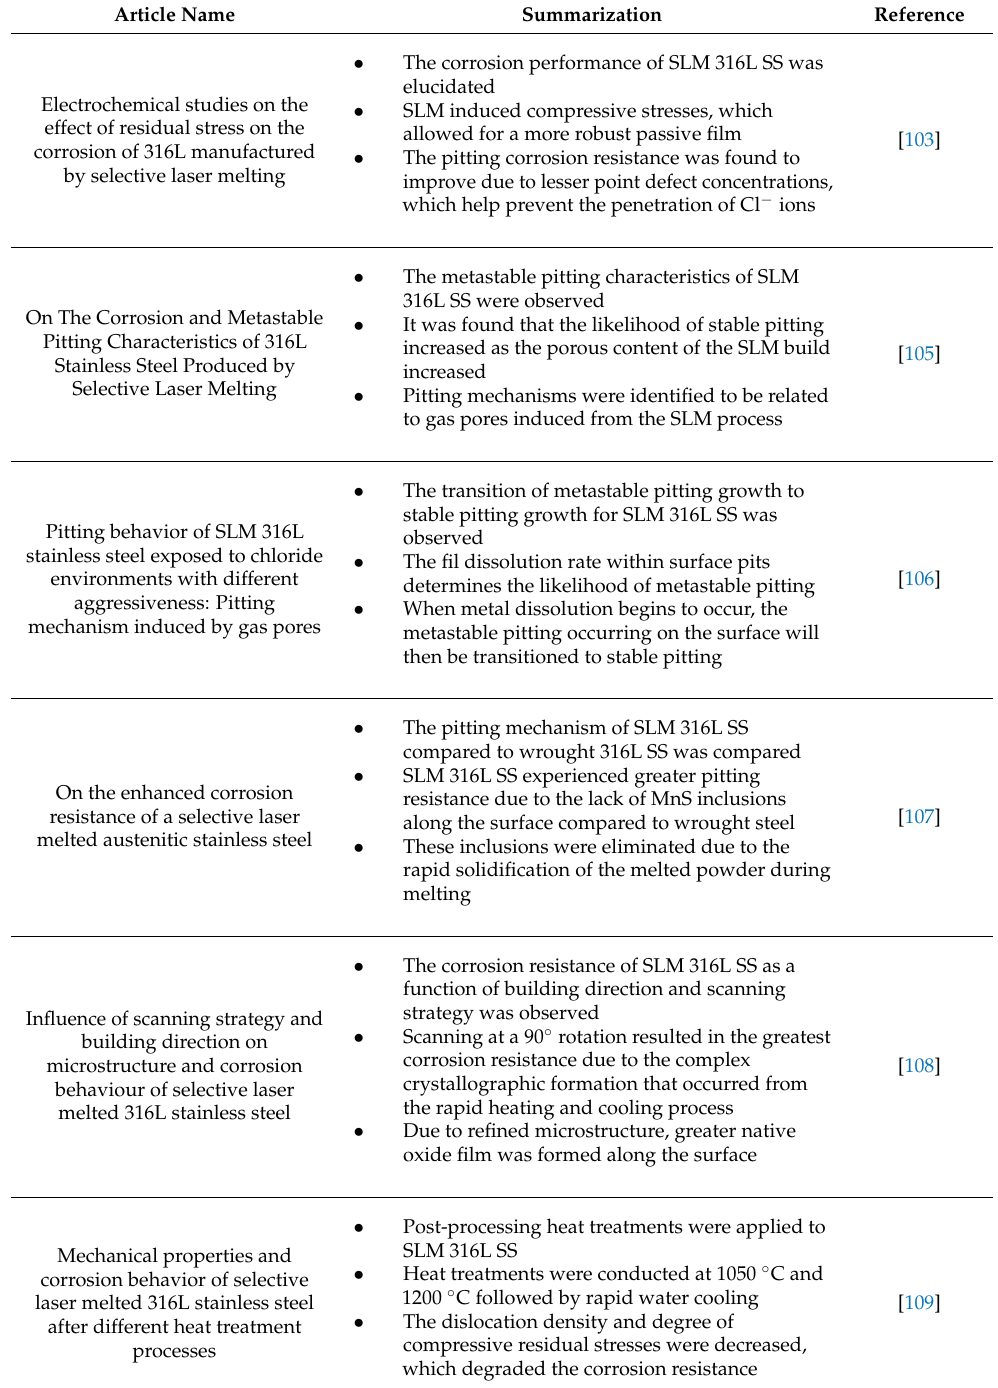
Table 4. Various publications summarize SLMs effects on the corrosion performance of SLM- manufactured